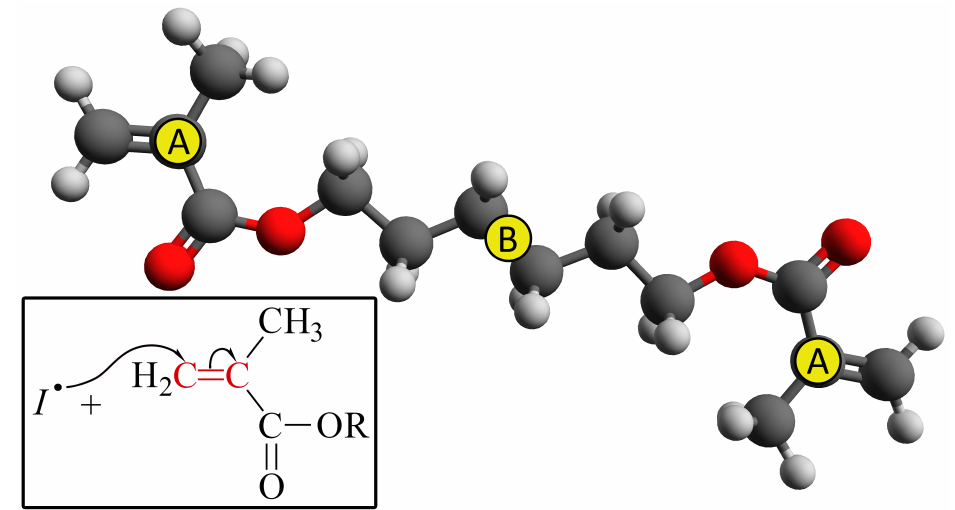
Figure 1. Structure of the 1,6-hexanediol dimethacrylate monomer. With yellow circles, the carbon atoms, of type A and B, used in the CG procedure as described in the text are